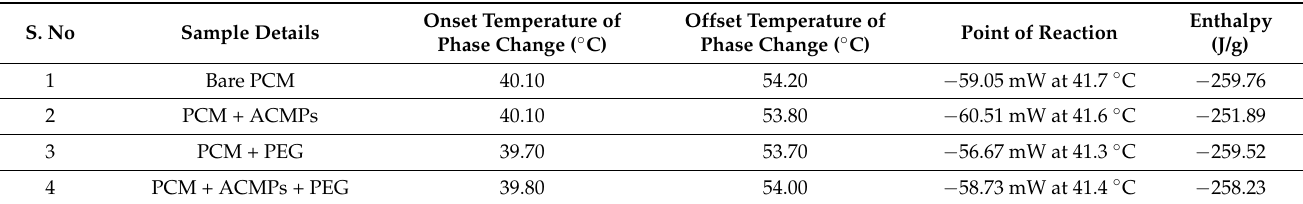
Table 3. Detailed thermal parameters of samples with optimum compositions.